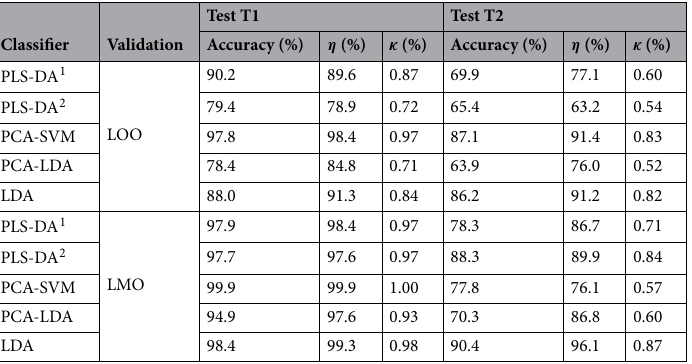
Table 1. Quality performance of classifiers expressed as the Accuracy, reliability index η 49 and Cohen’s